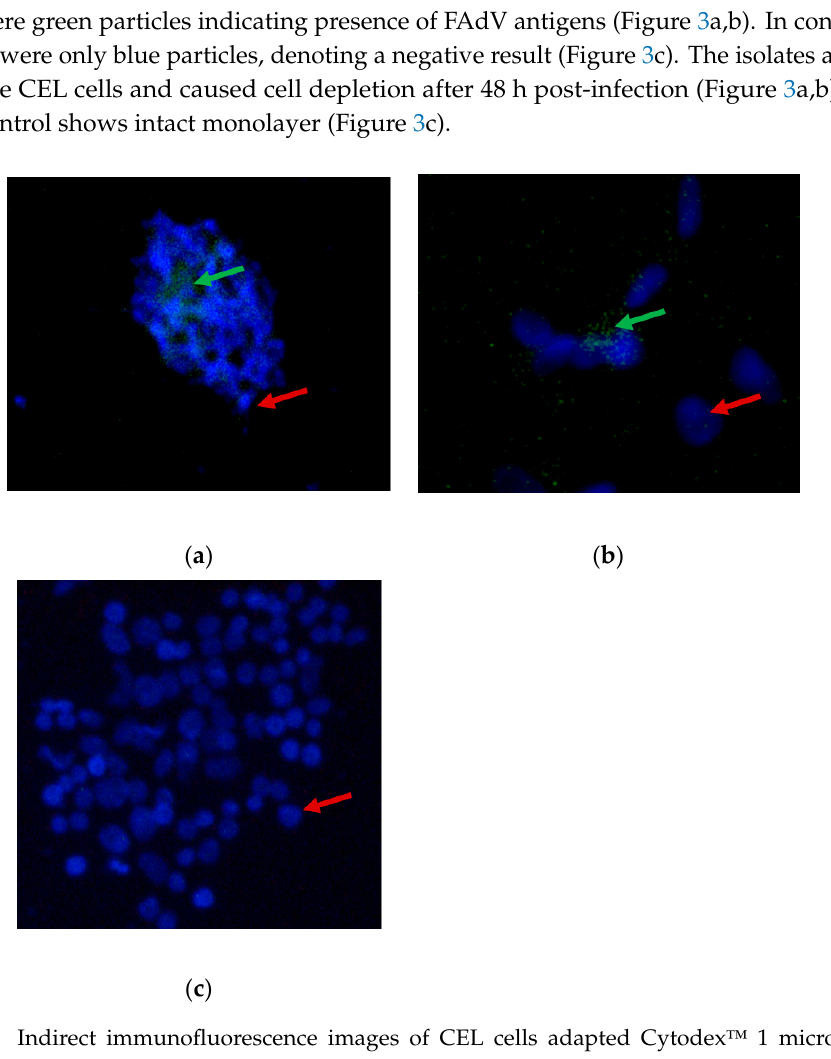
( b ) Figure 4. Transillumination image of PCR fragments showing agarose gel electrophoresis bands of ( a ) hexon and ( b ) fiber genes. Lane 1, FAdV Hexon positive control; Lane 2, UPM08136CELP5B1; lane